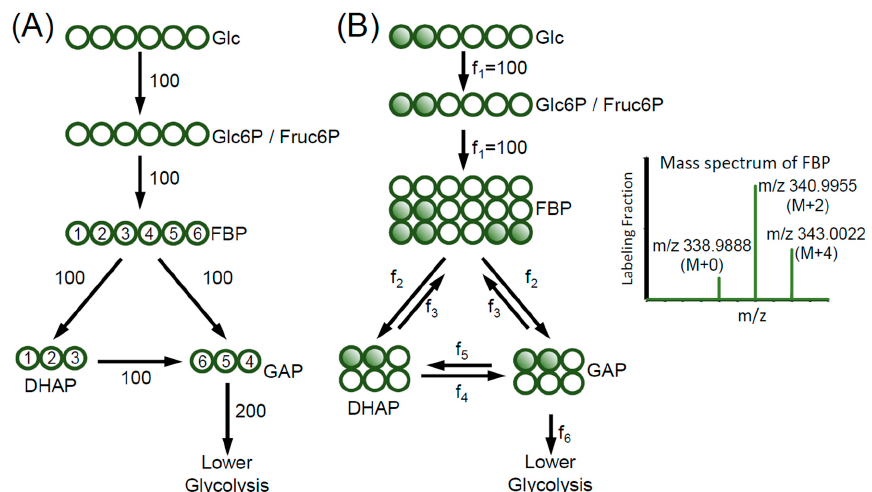
Figure 1. Comparison of stoichiometric flux analysis (SFA) and metabolic flux analysis (MFA). ( A ) For SFA, no isotope tracer is used. In the upper glycolysis network, the consumption rate of glucose and the production rate of GAP is 100 nmol/h and 200 nmol/h, respectively. The atoms of FBP, DHAP and GAP are numbered to illustrate the atom transition. ( B ) For MFA, 1,2- 13 C 2 -glucose is used as the tracer. As the result, FBP is labeled as M+0, M+2 and M+4. This labeling pattern indicates that the aldolase and triose phosphate isomerase have reverse fluxes, which are f 3 and f 5, respectively. The abbreviations used in the figure are: Glc, glucose; Glc6P, glucose-6-phosphate; Fruc6P, fructose-6- phosphate; FBP, fructose 1,6-bisphosphate; DHAP, dihydroxyacetone phosphate and GAP, glyceraldehyde-3-phosphate. The fluxes are in the unit of nmol/h. When the cells are at metabolic steady state, the production rate of an intercellular metabolite equals the consumption rates of it. Furthermore, when the cells are under isotopic steady state, the production rate of a specific labeling fraction equals the consumption rates of it. For FBP, such mass balances on the labeled fractions are described by the following equation.